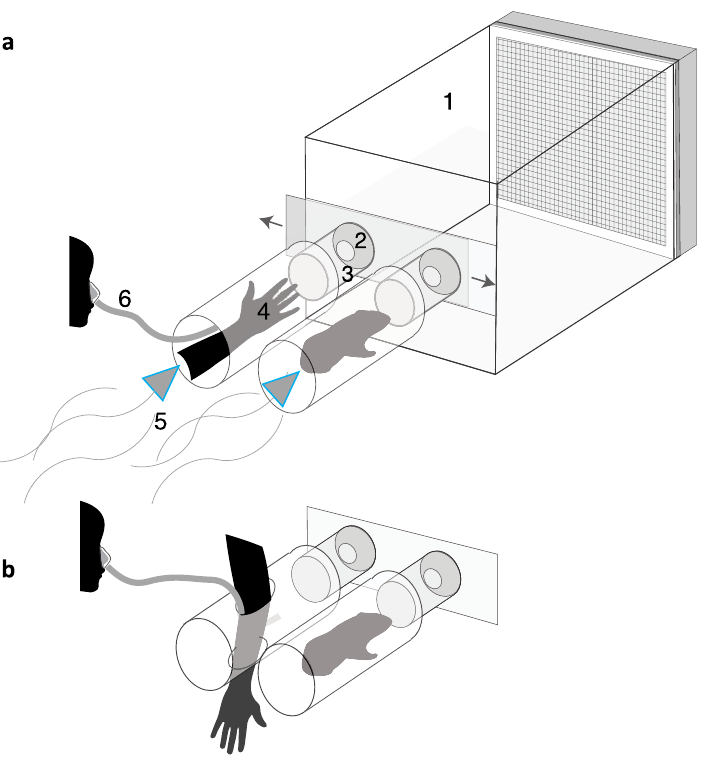
Figure 4. ( a ) The dual-port olfactometer consists of the following components: 1. the mosquito chamber, in which mosquitoes are released and allowed 10 min to acclimate prior to odor exposure; 2. funnel that allows mosquito entry into ports after the sliding door is opened but limits return of mosquitoes from the trap to the mosquito chamber; 3. mosquito trap, with a funnel on one end and a screen on the other to prevent access to hosts; 4. host chambers that hold the host for odor presentation; the method of human arm presentation pictured here was used in the second experimental round (the full forearm and hand were inserted through the far end of the tube and exposed to air flow, with the breathing tube inserted alongside the arm). An opaque panel (not pictured) divided the hosts from the mosquitoes such that they were not visible from the mosquito chamber prior to host choice; 5. wind source, which was created by blowing a carbon-filtered air source over the hosts in the first round (with a nozzle connected to each host chamber and an air outtake at the other end of the mosquito chamber; ~ 0.6 m/s windspeed), and in the second round, created by a window fan fitted to the far end of the mosquito chamber, producing air flow by sucking air from the room through the host chambers and the mosquito chamber. ( b ) In the first experimental round, the human arm was displayed by inserting the arm perpendicularly through the host chamber, with the hand protruding from the opposite side, such that the elbow was exposed to air flow. The breathing tube (6) was also inserted into the host chamber. Schematics modified from Metz et al. (2022) 53